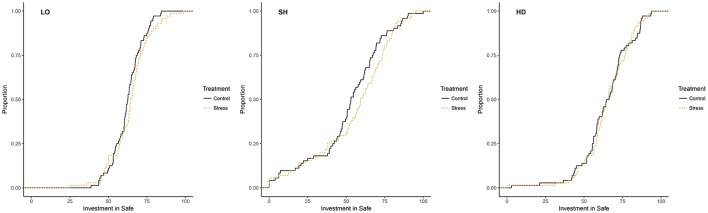
Distribution of average amounts in Safe by task and treatment.